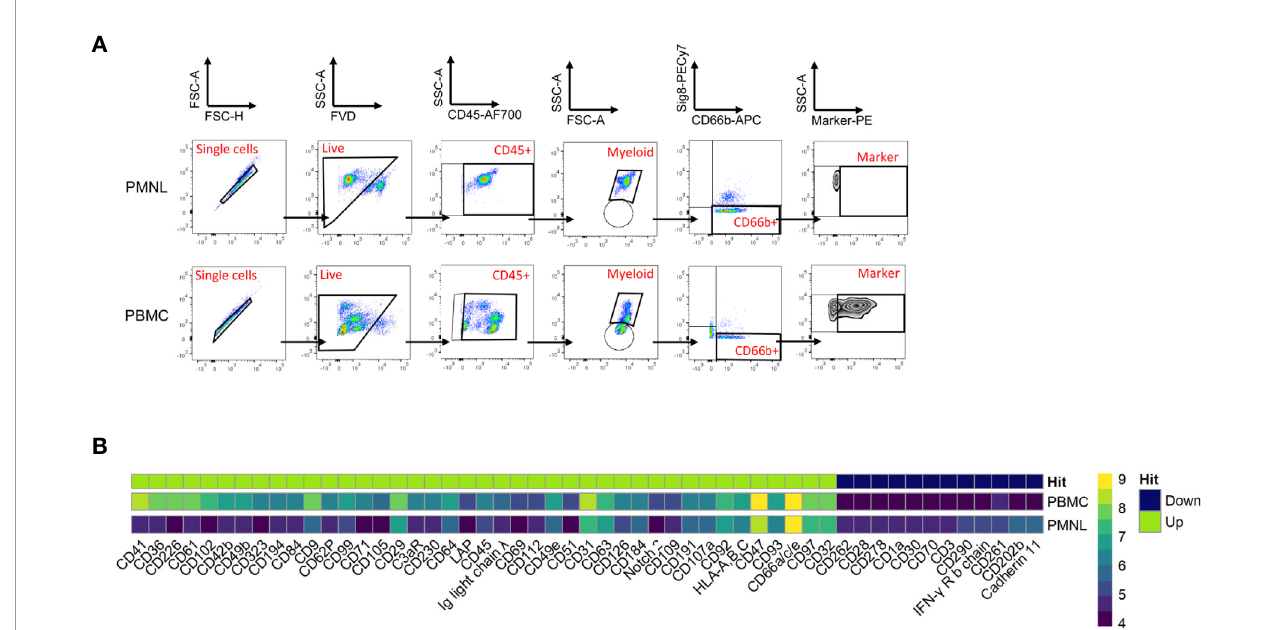
FIGURE 2 | Comprehensive surface marker screening in PMNLs and PBMCs from NSCLC patients. PBMCs and PMNLs were isolated from peripheral blood of NSCLC patients by density gradient centrifugation. Cells were initially stained with a backbone panel including antibodies against CD45, CD66b and Siglec8 and then distributed and stained with 361 anti-human PE-conjugated variable antibodies (Legend Screen, Biolegend). (A) Representative fl ow cytometry dot plots demonstrating the gating strategy employed to identify the PE-conjugated cell surface markers in the HDN and LDN fractions. Initial gate is to eliminate doublets from the analysis followed by gating on live (FVD) and CD45 + cells. The myeloid population (containing neutrophils and eosinophils) was gated based on its forward and side scatter properties. Neutrophils (HDNs in PMNL fraction and LDNs in PBMC fraction) were identi fi ed as CD66b + Siglec8 - cells and PE channel was used to analyze the individual surface markers. (B) Expression heatmap of marker hits. Hits were de fi ned by fold change marker expression (GeoMean) with fold change > 2 and < 0.5 (ratio LDN/HDN) (see details Supplementary Table 2 ). Heatmap scale represents the GeoMean and ‘ hits ’ show the differentially regulated markers in the LDNs (PBMC gated) vs HDNs (PMNL gated); green-overexpressed, dark